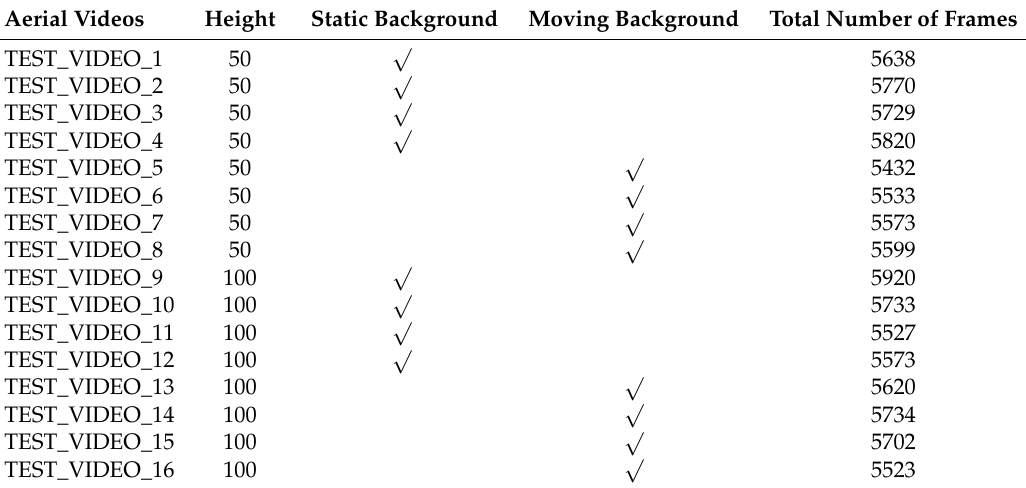
Table 1. The information of test data.